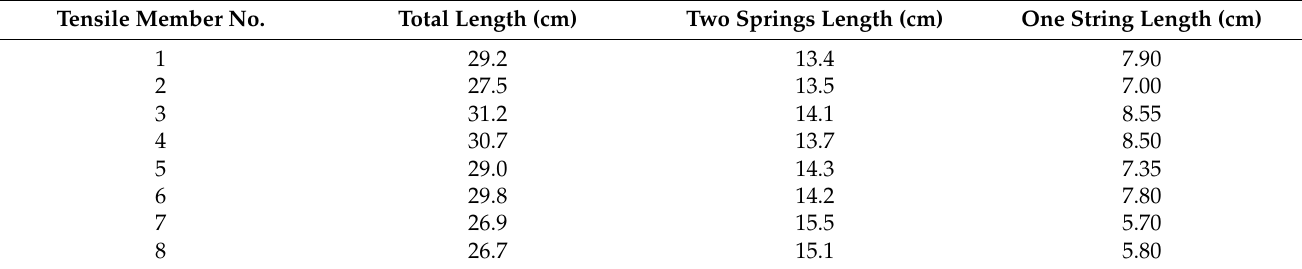
Table 3. The total length, the length of the two springs section, and the length of one string of the tensile member from No.1 to No.8. These tensile members consist of two springs with strings attached to each end.